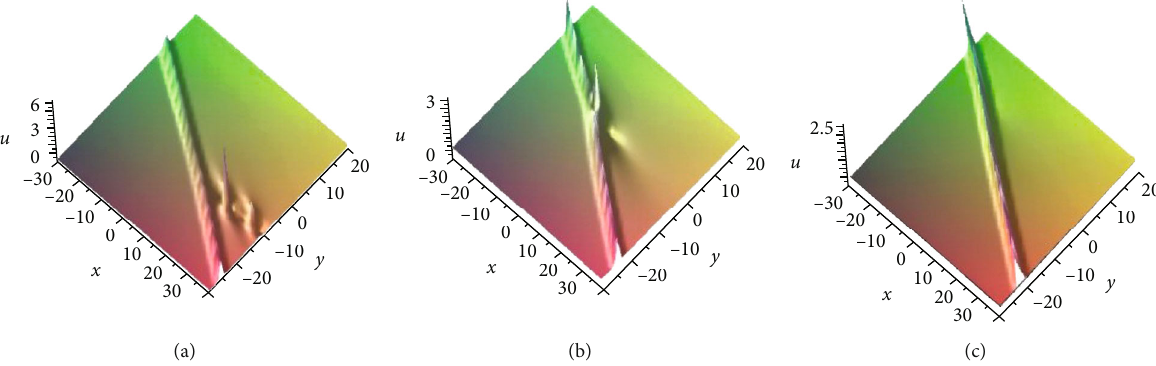
, where G is given by (34) with p 1 = 1 + i , q 1 = 1 − i , a = 1 , b = 1 , τ = 0 , c 12 = 1 , xx